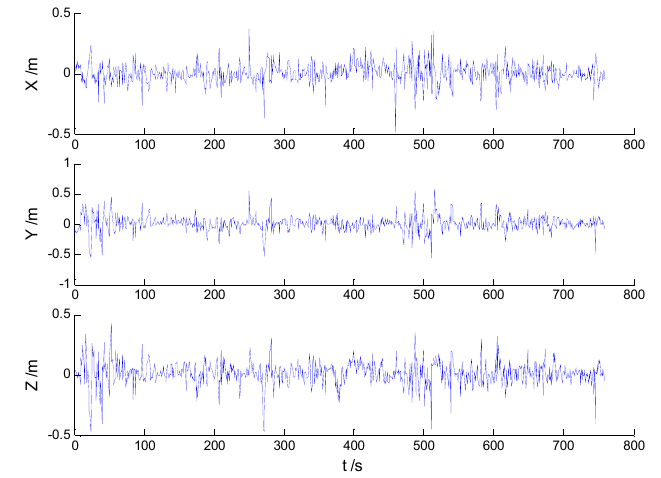
Figure 13. Position errors of the AHF algorithm.